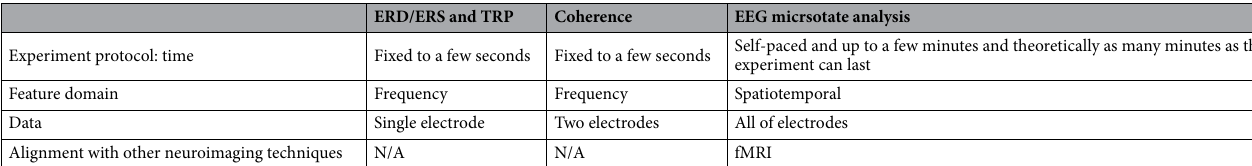
Table 1. Method comparison between conventional power analysis and EEG microstate